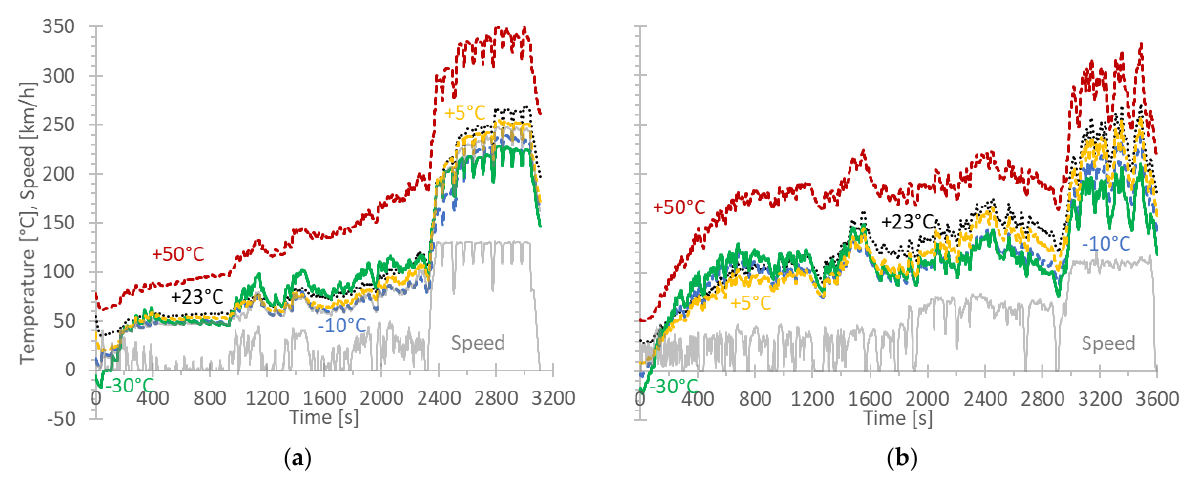
Figure A2. Exhaust gas temperature: ( a ) TfL + BAB; ( b ) RDE